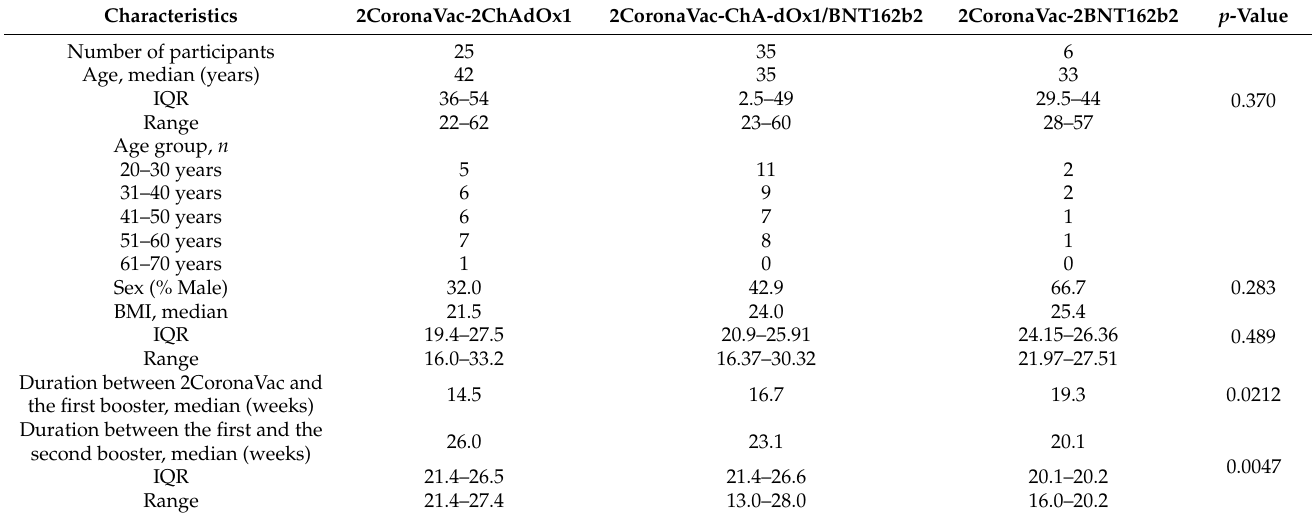
Table 2. Demographic data of participants who had received primary vaccination by CoronaVac